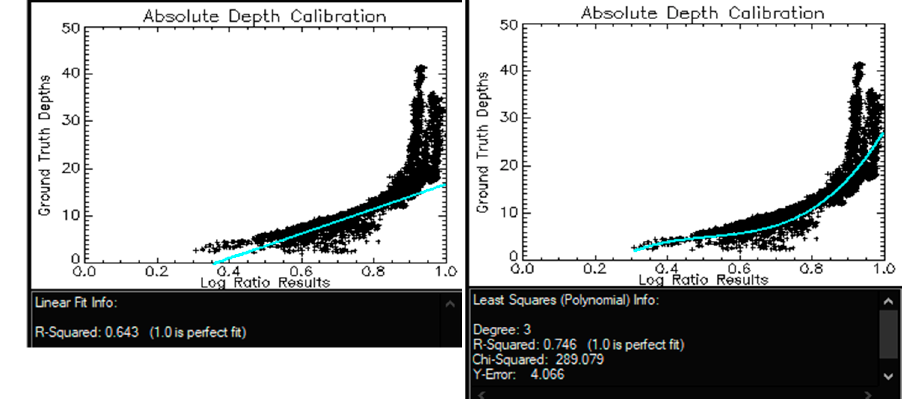
Figure A9. From 8 March 2014.